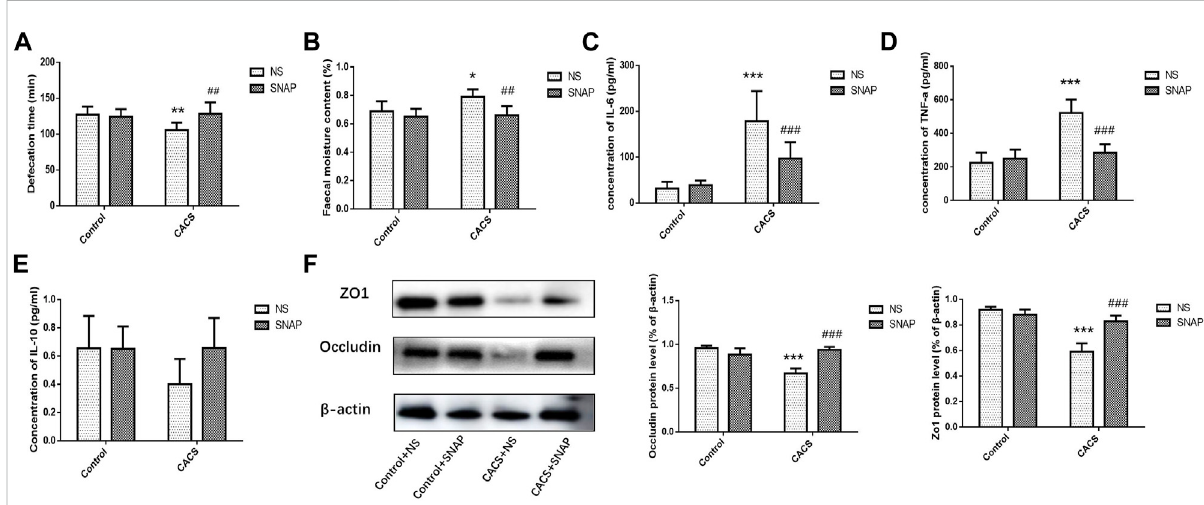
FIGURE 6 MicroinjectionofSNAPinBLAaffectedintestinalcharactersinCACSmice. (A,B) Changesinfecalexcretiontime (A) ,fecalwatercontent (B) ,and the effects of injecting SNAP into the BLA on fecal excretion time and fecal water content. (C,D,E) Changes in IL-6, TNF- α , and IL-10 in the colon tissues of the CACS model mice and the effects of injecting SNAP in the BLA on IL-6, TNF- α , and IL-10 in the colon tissues of the CACS model mice. (F) Changes in occludin and ZO1 in the colons of the CACS model mice and the effect of injecting SNAP in the BLA on occludin and ZO1 in the colons oftheCACS modelmice. Thedataare presentedas themean±SEM( n =6 – 10miceper group).* p < 0.05, ** p < 0.01,*** p <